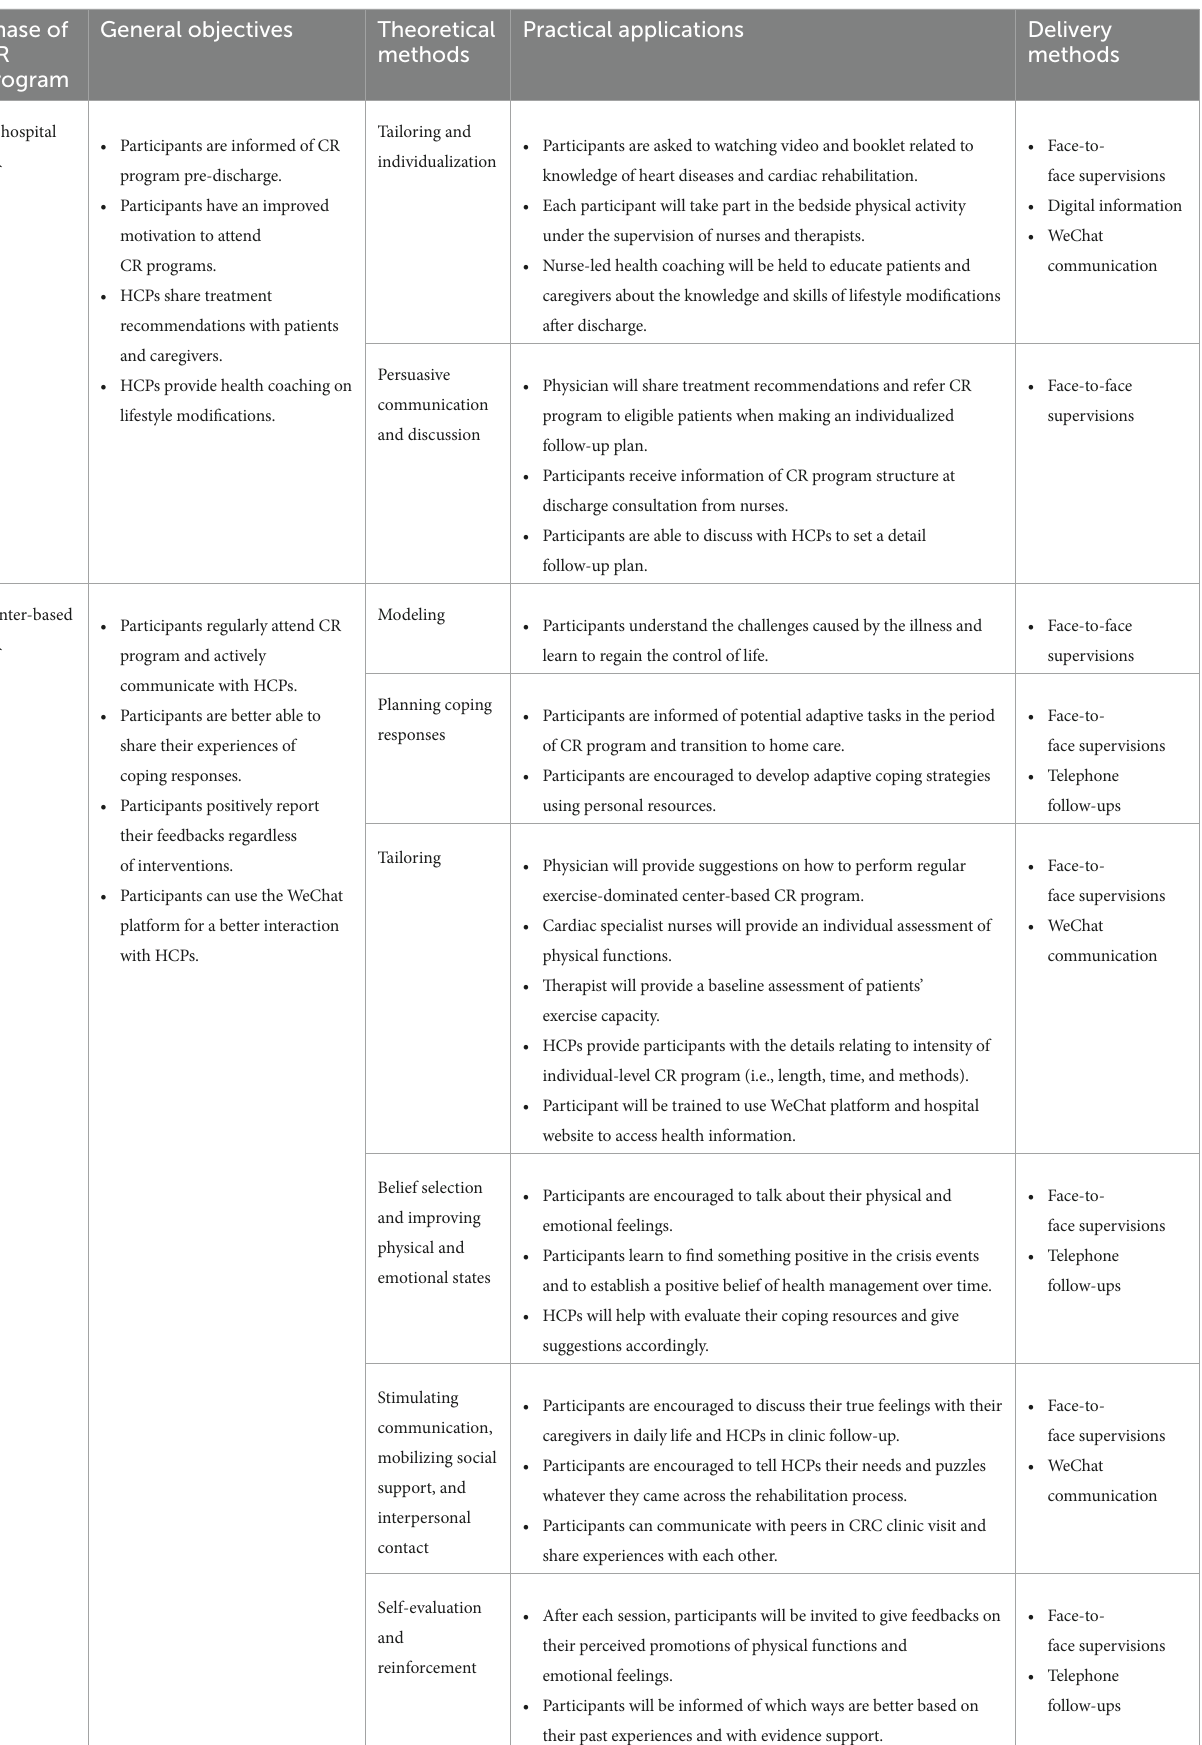
TABLE 2 Implementation intervention plan for the integrated cardiac rehabilitation program. Phase of CR